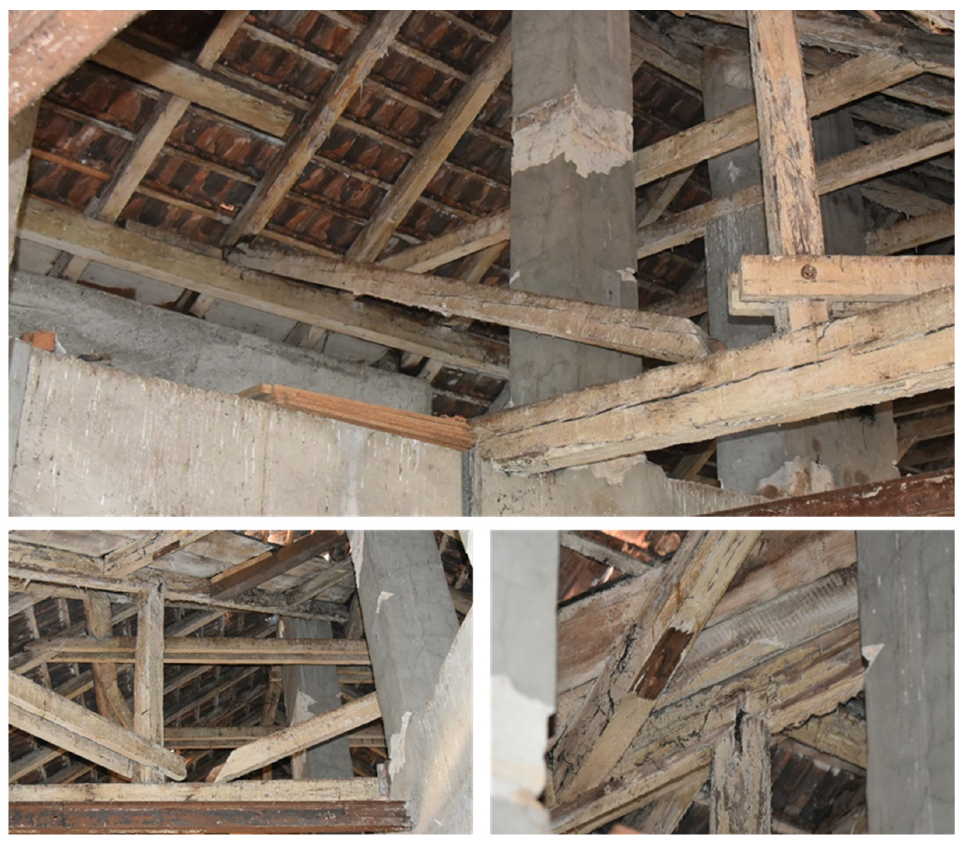
Figure 19. Overview of damage element after earthquakes impact—the collapse of the collar beam element due to ejection under the distribution of forces (from compression to tensile).